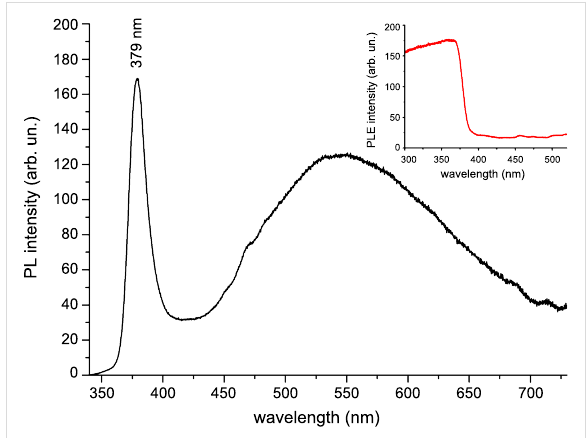
Figure 2: Room-temperature PL spectrum of the ZnO nanowire film. The insert is a PLE spectrum.